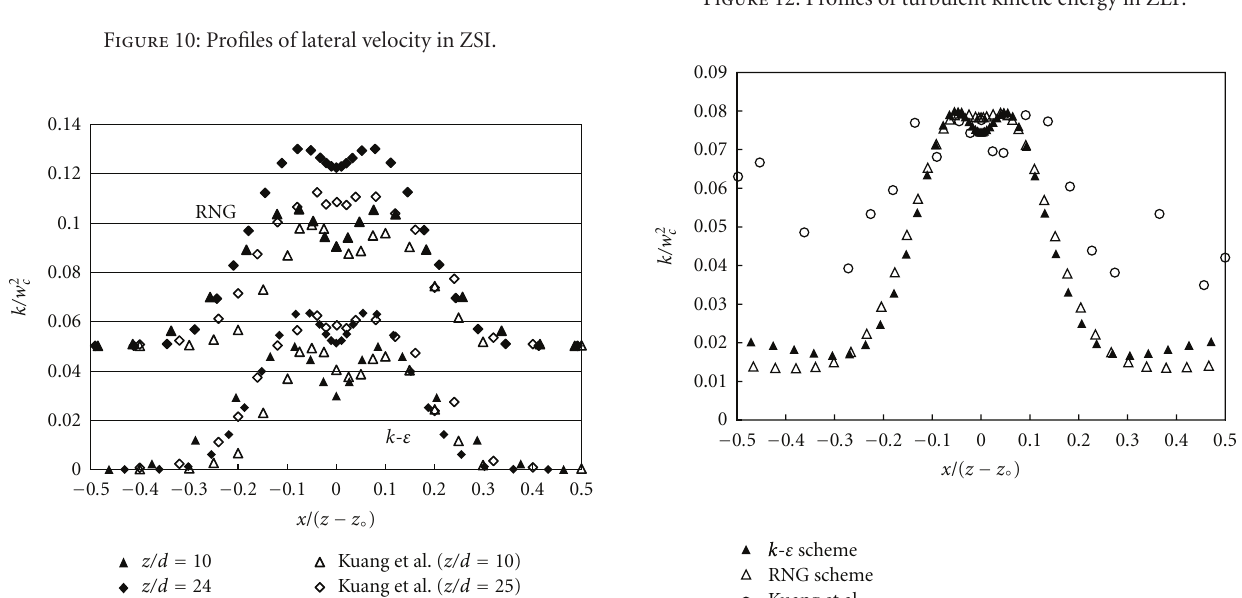
Figure 12: Profiles of turbulent kinetic energy in ZEF.